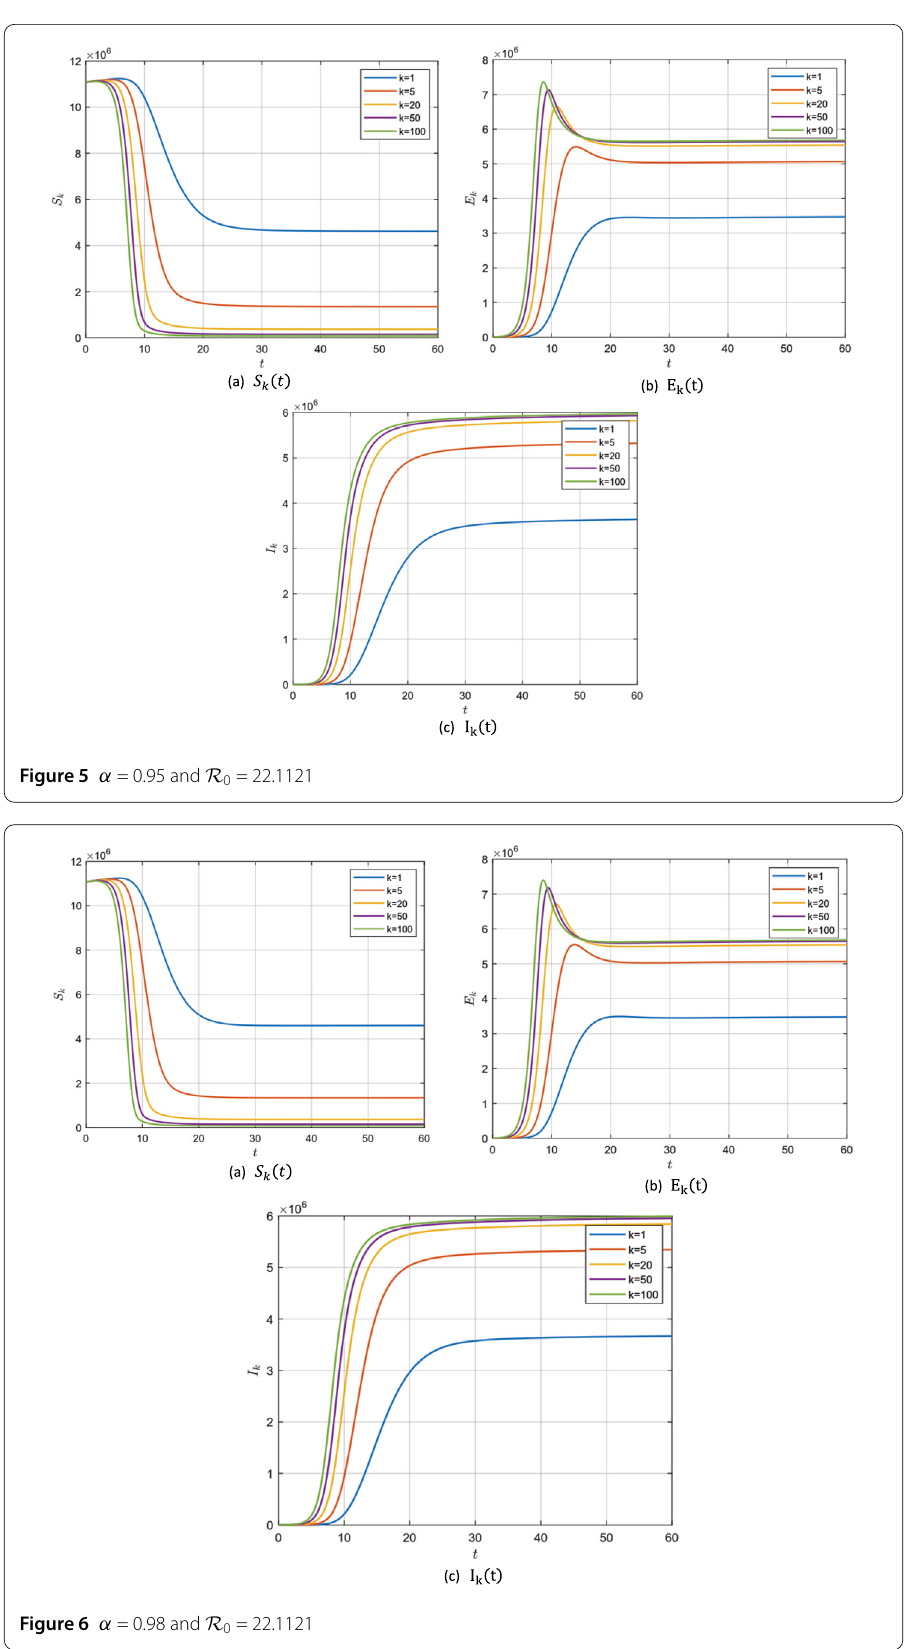
Figure 6 α = 0.98 and R 0 =